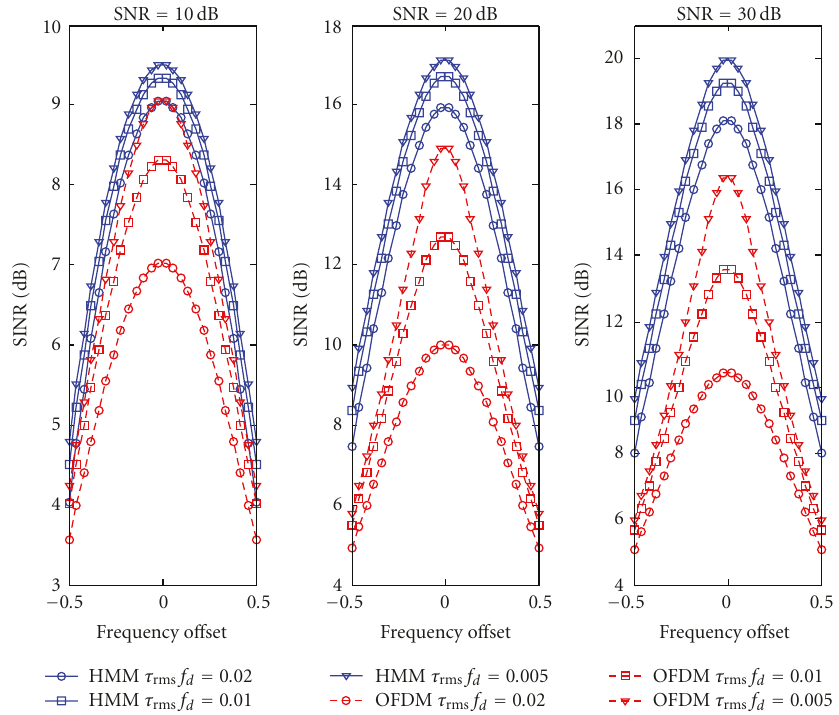
Figure 3: SINR for hexagonal multicarrier system for Δ f ∈ [ − 0 . 5,0 .